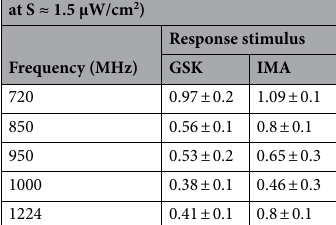
Table 1. Lists the measured cell recombination fraction (+EMF/−EMF) at a relative constant power flux density S value of 1.5 µW/cm 2 for all tested frequencies.